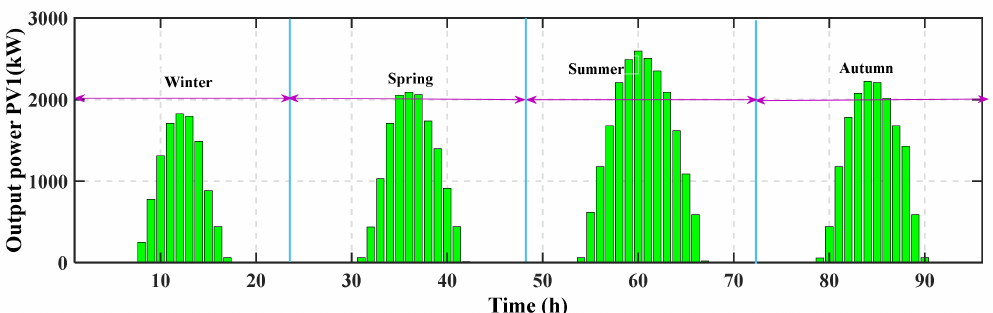
Figure 10. The outputted power from the first unit for case 2.